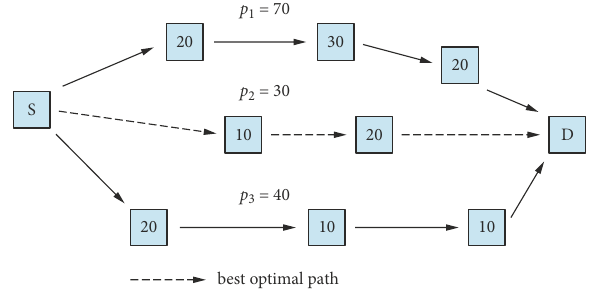
Figure 5. Best optimal path selection Figure 6. Coordinates of vehicles in the